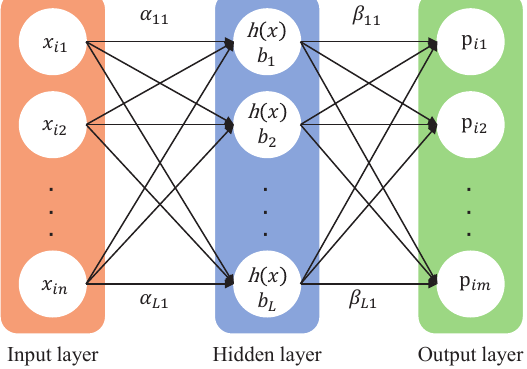
Figure 1. The three layers of an extreme learning machine with one hidden layer in which α denotes the input weights, β denotes the output weights, and b is the hidden layer